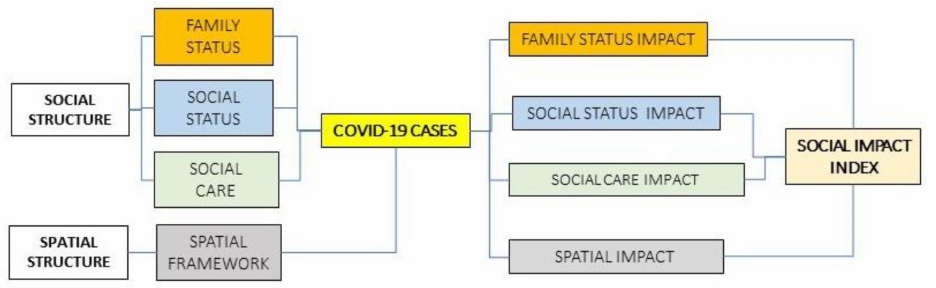
Figure 1. Scheme of the proposed model. Source: Author.